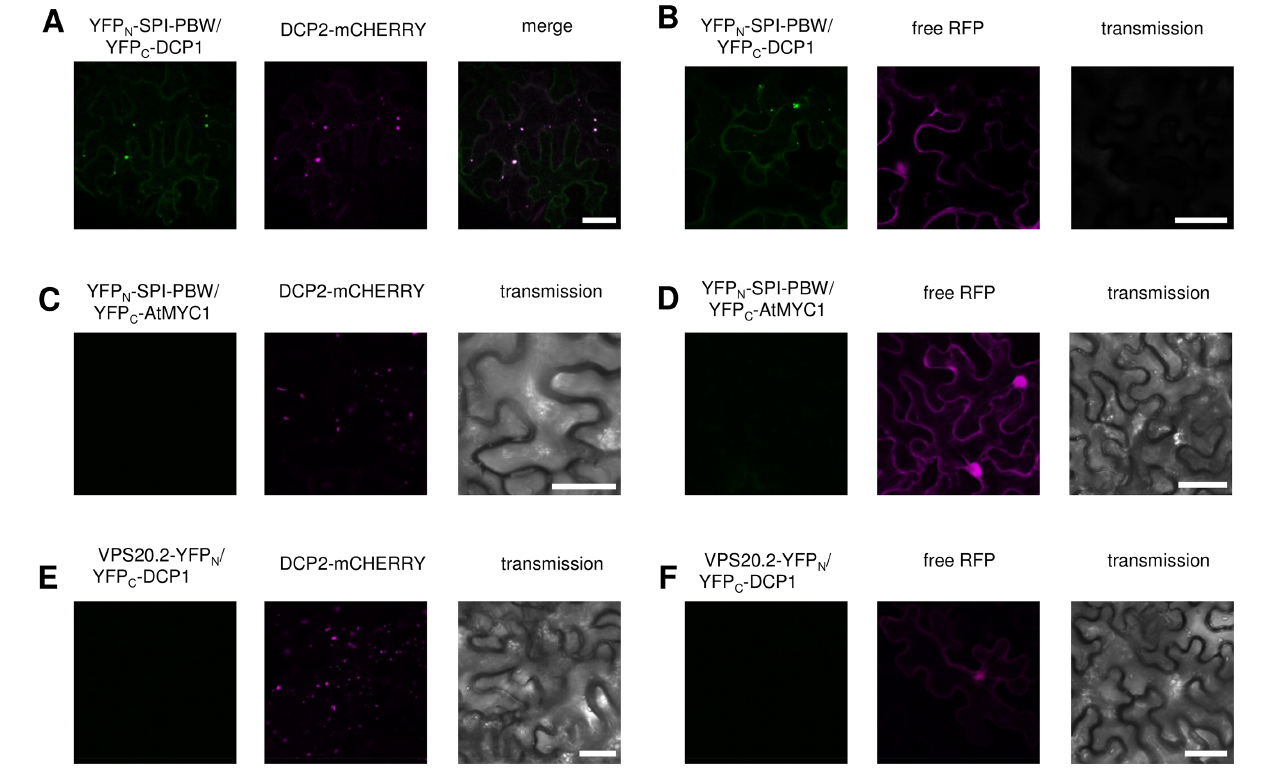
Fig 2. SPI and DCP1 interact at P-bodies in BiFC assays. Fusion proteins are expressed under the control of the 35S promoter. (A) Interaction of YFP N - SPI and YFP C -DCP1 (left) in transiently transformed N . benthamiana leaves 72 h post-transfection at DCP2-mCHERRY labeled P-bodies (middle). Right pictures show the overlay of the left (green) and middle (magenta) pictures. (B) Interaction of YFP N -SPI and YFP C -DCP1 in cytoplasmic dots (left) in N . benthamiana leaves coexpressing free RFP as transformation control (middle). Right pictures show the corresponding transmission picture. (C – F) Representative images of BiFC negative controls. No YFP signal in leaf epidermis cells coexpressing YFP N -SPI-PBW and YFP C -AtMYC1 in combination with DCP2-mCHERRY (C) and free RFP (D). No YFP signal in leaf epidermis cells coexpressing YFP C -DCP1 and VPS25-YFP N in combination with DCP2-mCHERRY (E) and free RFP (F). Scale bar: 50 μ